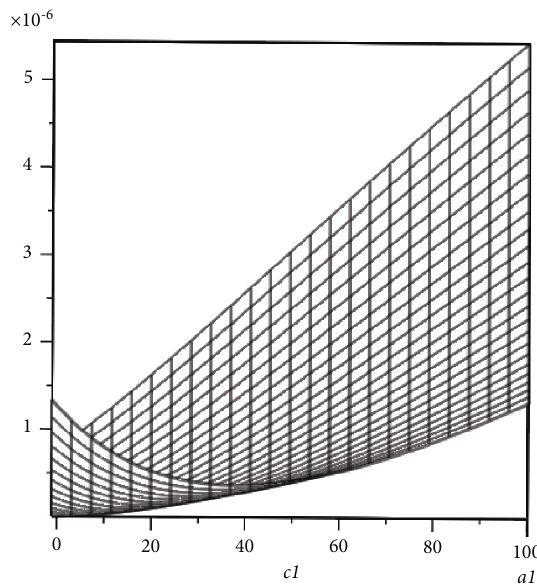
Figure 8: The projection of the graph of the data ( a a − G plane when − 100 ≤ a 1 1